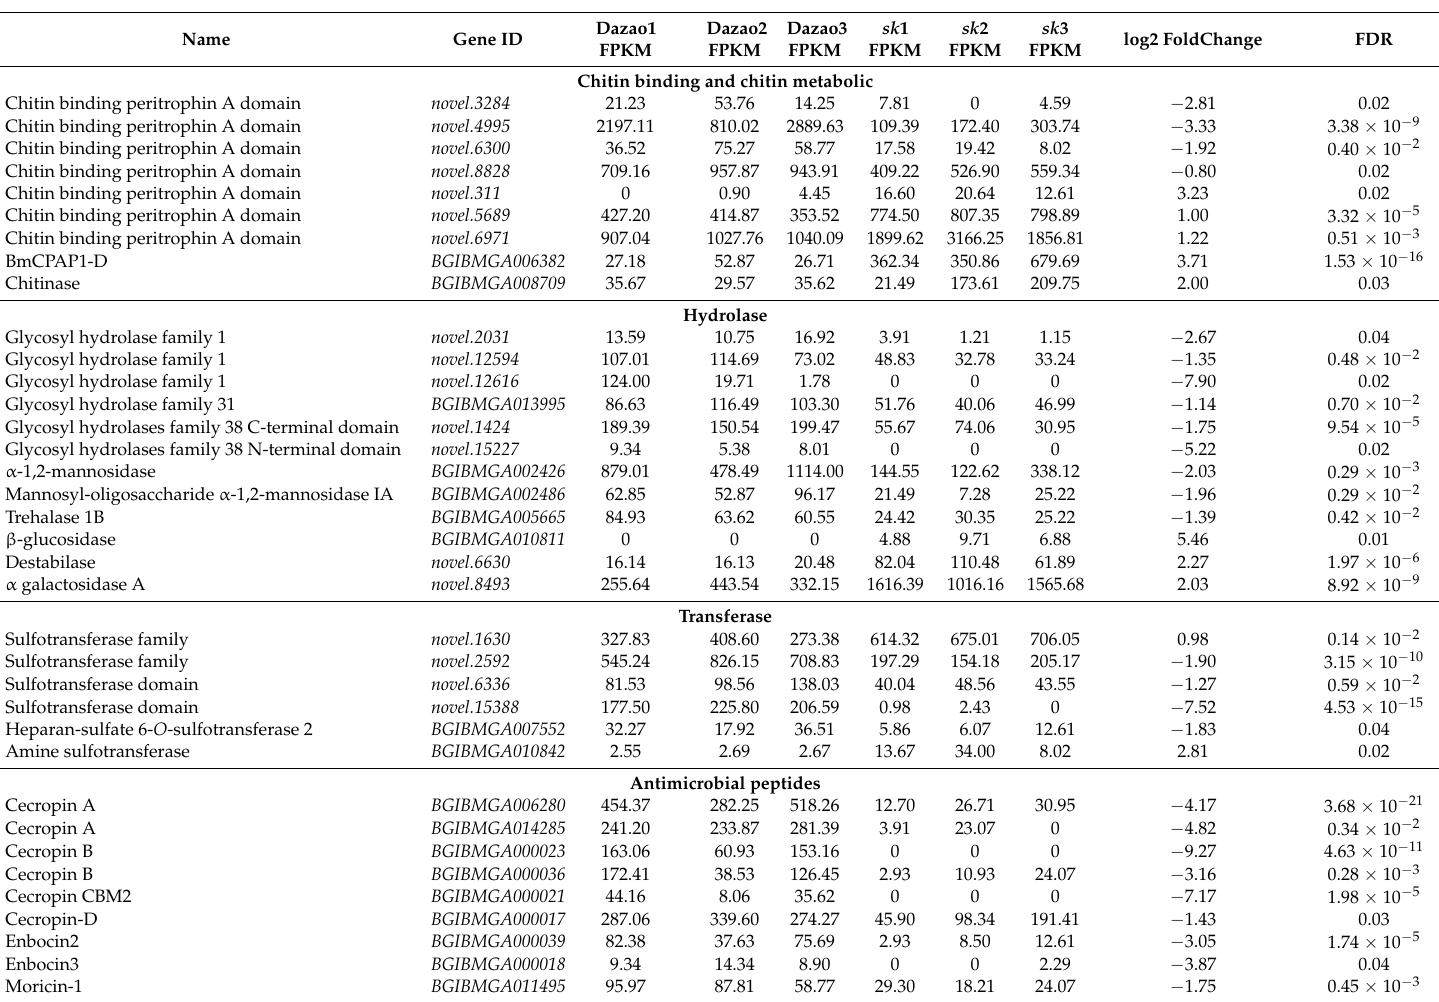
Table 2. DEGs involved in chitin metabolic and chitin binding, defense and immune, hydrolase, transferase between wild-type and sk